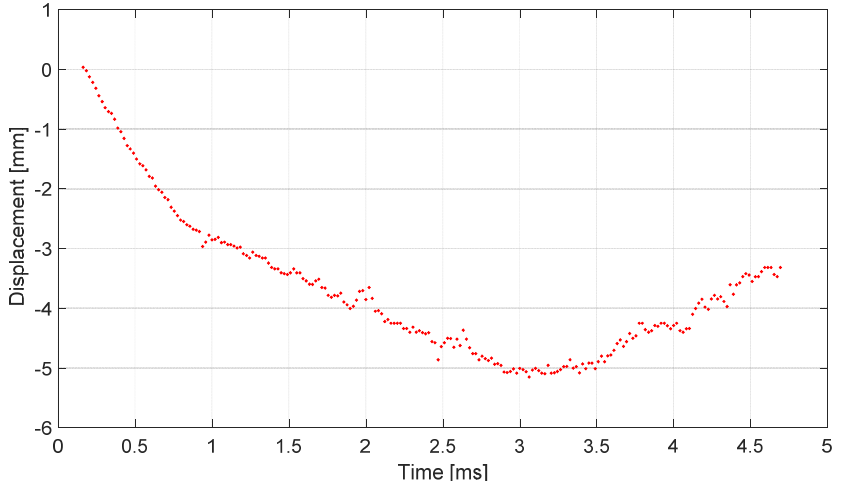
Figure 4. Time-displacement curve of the concrete specimen obtained during the experiment using an optoNCDT 2300 laser sensor.